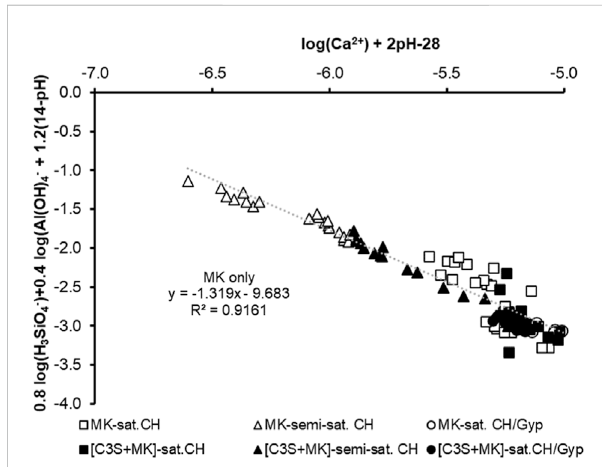
FIGURE 11 Equilibrium-plot of C-A-S-H using the measured ion concentrations of the aqueous phase of MK- and [C 3 S + MK]- suspensions with saturated (squares) and semi-saturated (triangles) Ca(OH) 2 -solutions as well as saturated Ca(OH) 2 -CaSO 4 - solutionsasstartingsolution.Thelinearregressioniscalculatedforthe MK-data